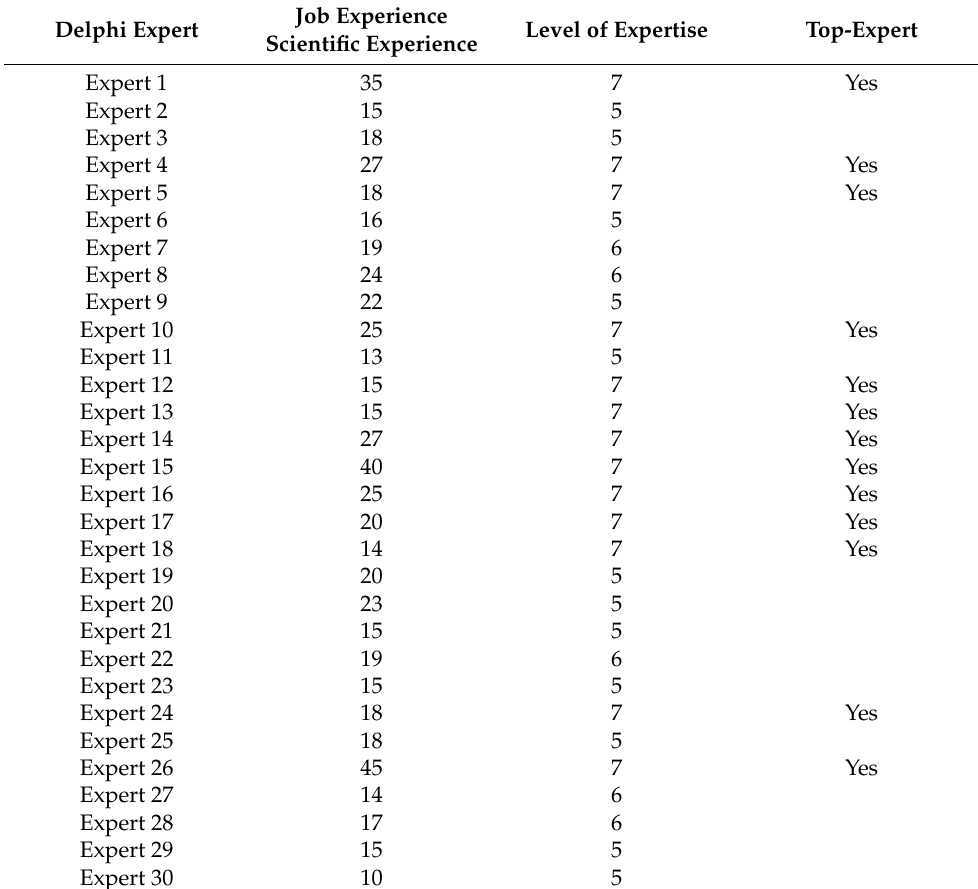
Table 1. Demographics Delphi